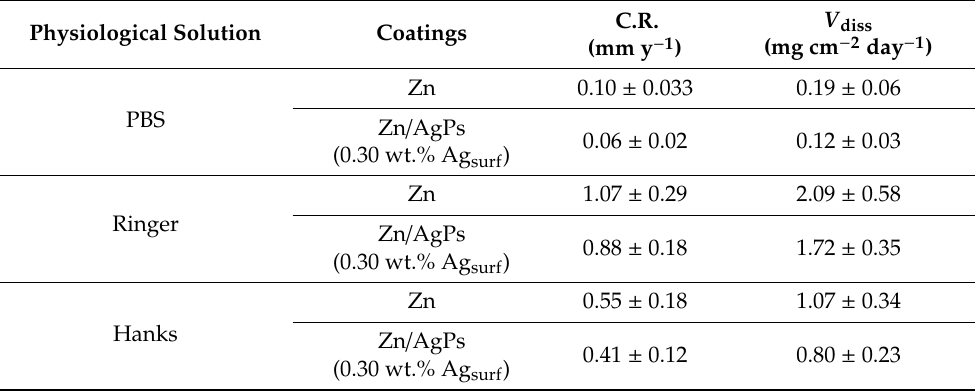
Table 5. Corrosion rate (CR) of Zn coatings and Zn / AgP (0.30 wt.% Ag surf ) composite coatings after immersion in di ff erent physiological solutions for 40 days at 37 ◦